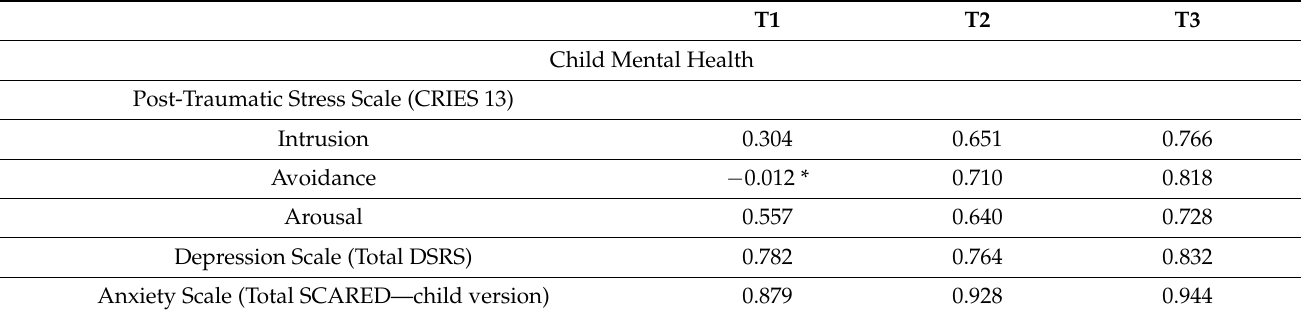
Table A1. Reliability assessment (Cronbach’s alpha) of scales used over